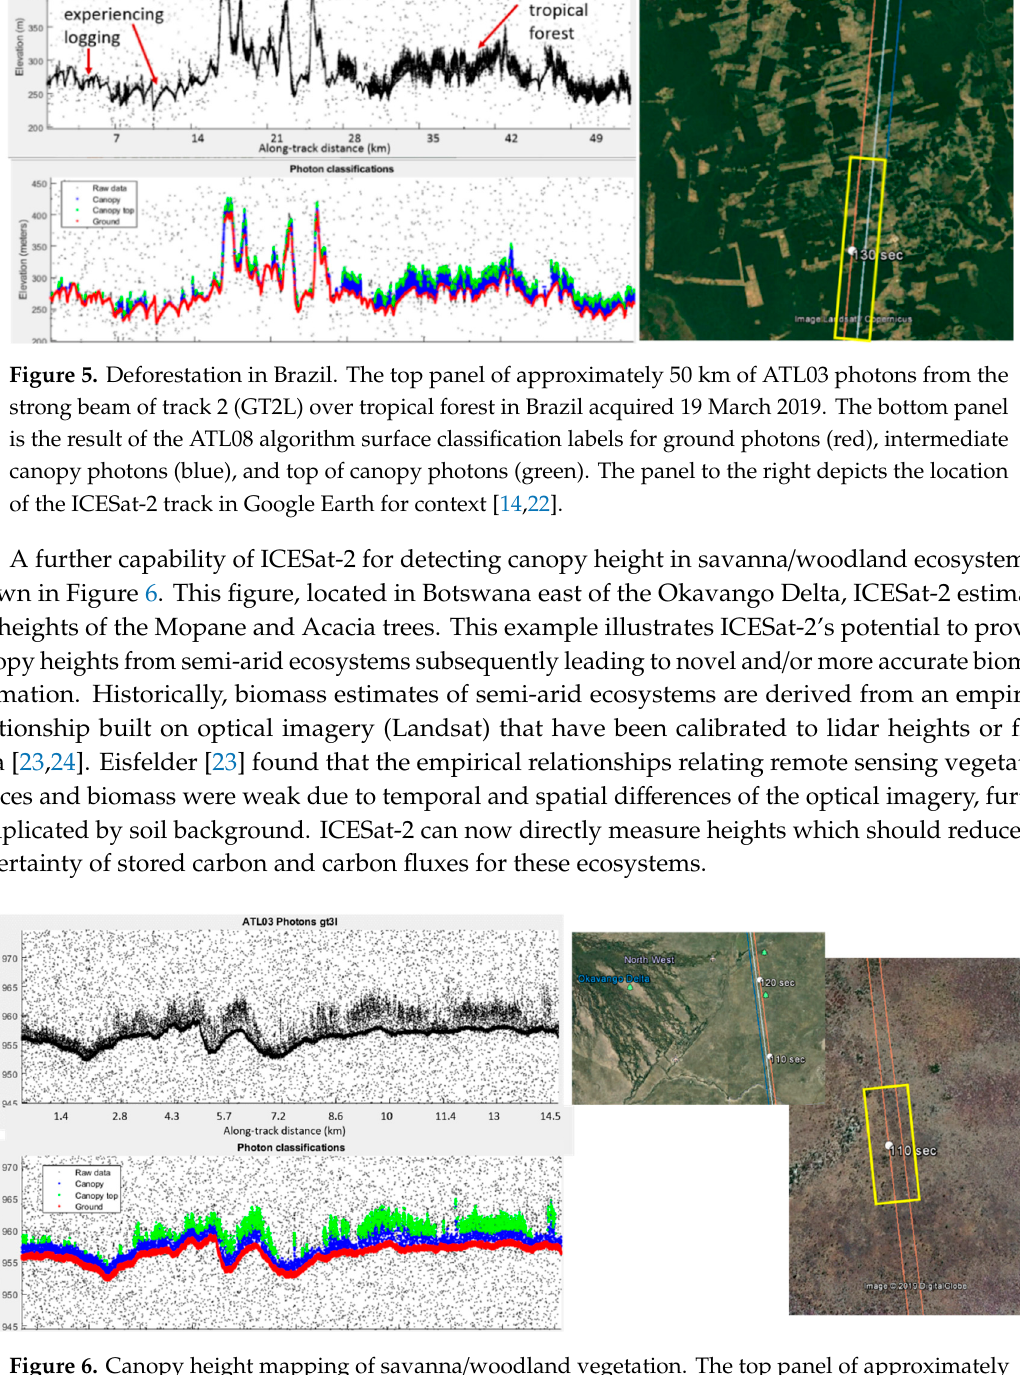
Figure 6. Canopy height mapping of savanna / woodland vegetation. The top panel of approximately 14 km of ATL03 photons from the strong beam of track 3 (GT3L) over Mopane woodlands in Botswana acquired on 3 February 2019. The bottom panel is the result of the ATL08 algorithm surface classification labels for ground photons (red), intermediate canopy photons (blue), and top of canopy photons (green). The panel to the right shows the ICESat-2 tracks across the landscape for context [14,25].